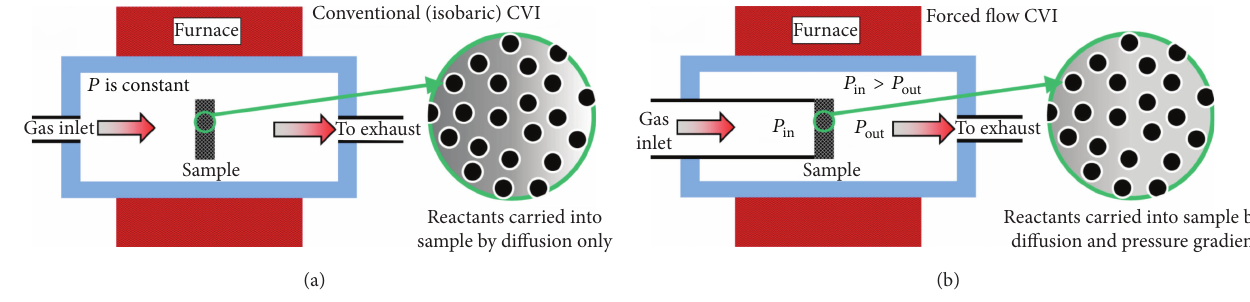
Figure 1: (a) Schematic of conventional (isobaric) CVI and (b) schematic of forced flow or pressure gradient